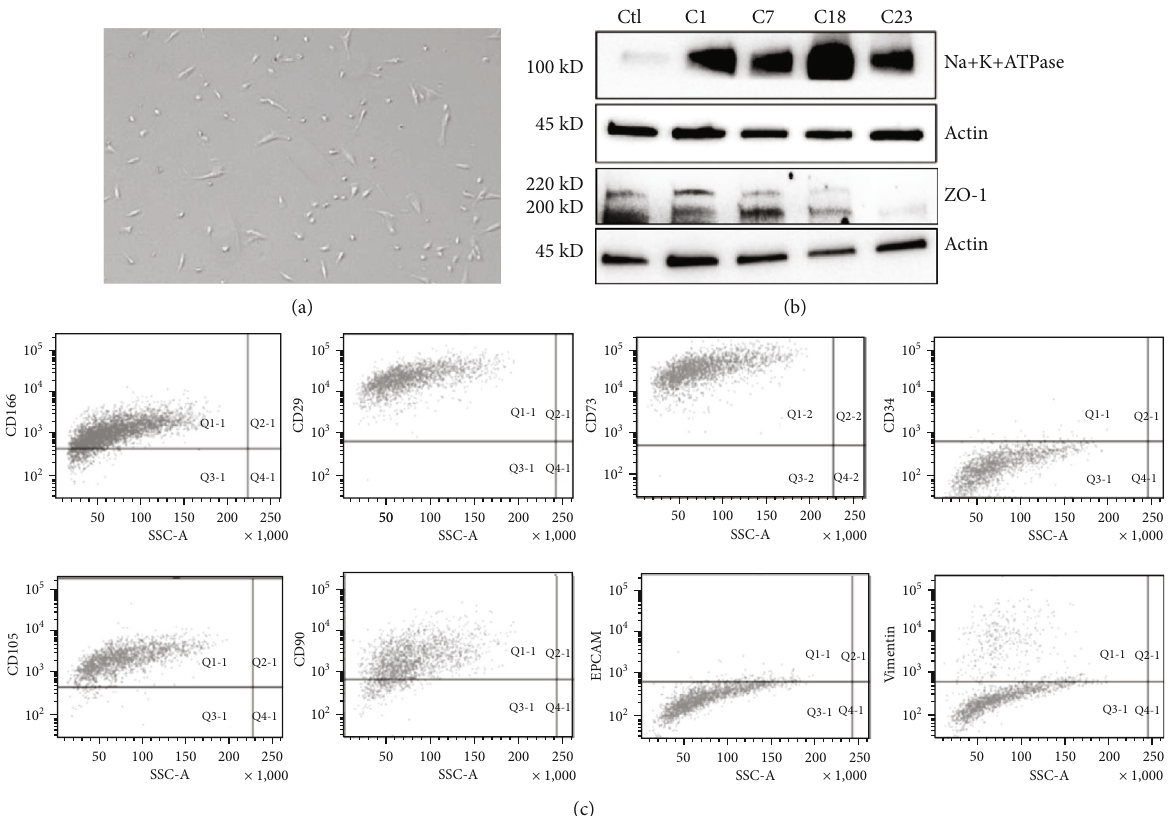
Figure 1: Isolation and characterization of corneal endothelial cells. (a) Representative micrograph of HCEC at passage 3. (b) Representative micrographs of western blot on four HCEC independent cell lines deriving from di ff erent patients (C1, C7, C18, and C23). The control (Ctl) is represented by the renal HK2 cell line, negative for Na+K +ATPase and positive for ZO-1. Actin was used as an endogenous loading reference. (c) Representative fl ow cytometry analysis of HCECs showing the expression of CD166, CD105, CD29, CD90, CD73, CD34, EPCAM, and Vimentin on